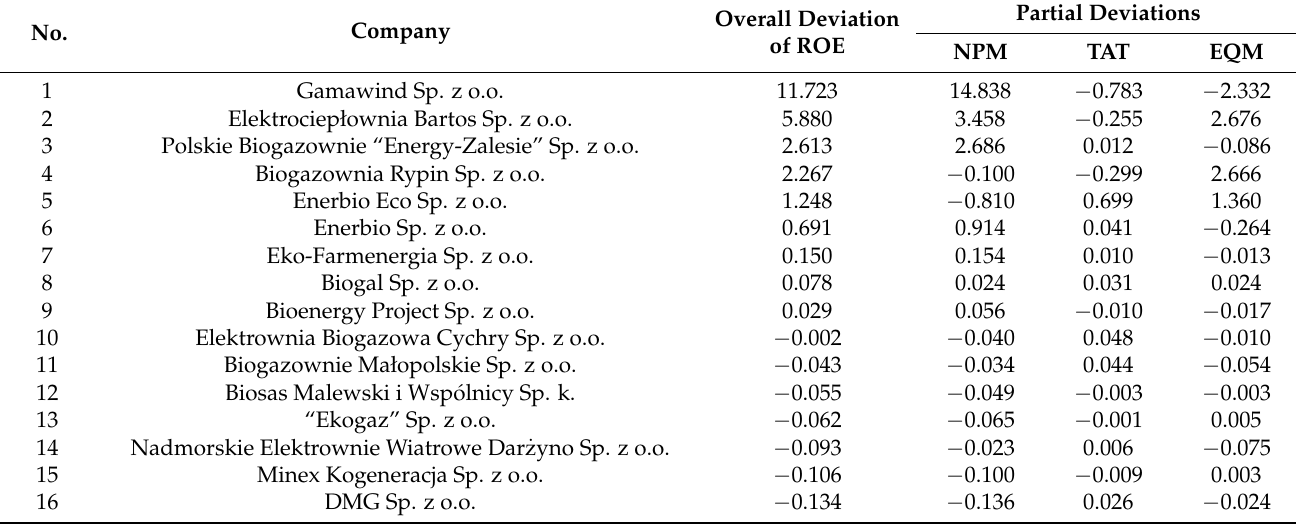
Table A2. Results of causal analysis using the Du Pont model for